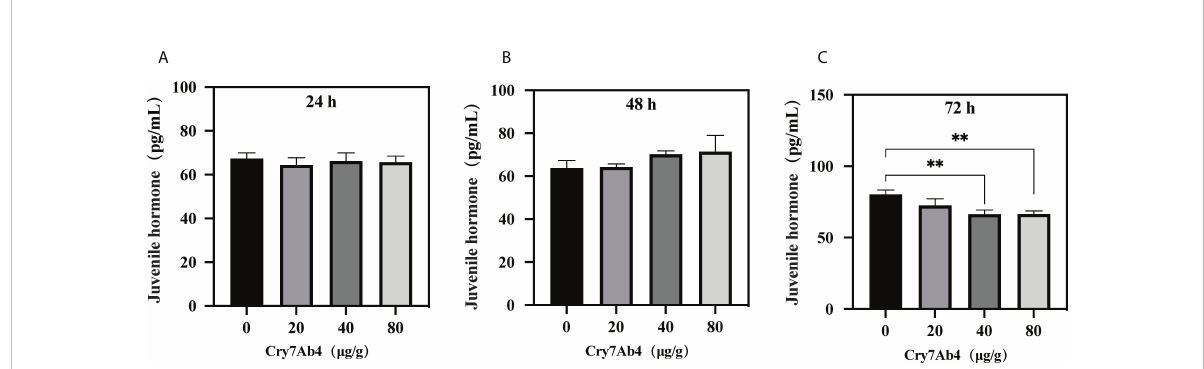
FIGURE 6 Feeding Cry7Ab4 toxin decreased the free JH level in P. xylostella larvae. P. xylostella larvae (second instar, day 2) were fed a diet containing Cry7Ab4 toxic core, and free JH level in the larvae was determined at 24 (A) , 48 (B) , and 72 h (C) after feeding toxin. A signi fi cant difference was determined by Student ’ s t-test between two groups, indicated by **( p < 0.01).